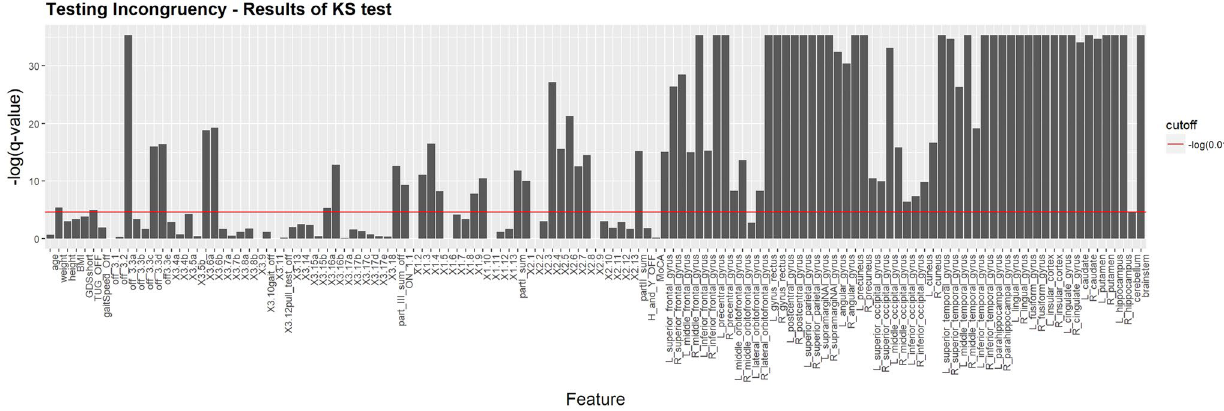
Figure 5. Results of KS tests on 126 features comparing the distributions in Michigan and Tel-Aviv data. The red horizontal line represents the cutoff of − log ( α ), where α (desired FDR) =